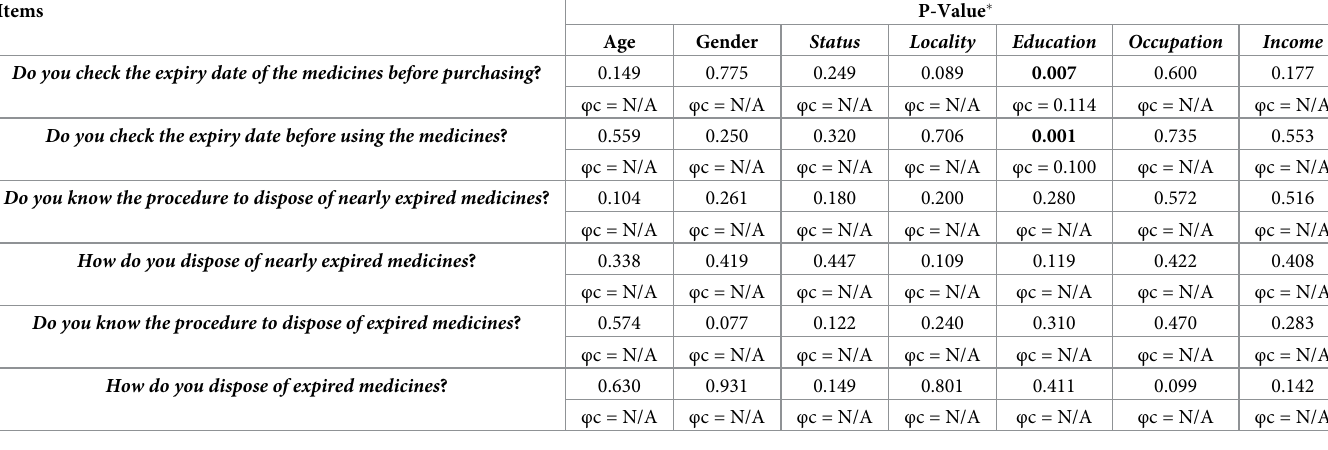
Table 5. Association between storage, and disposal practices of expired medicines and